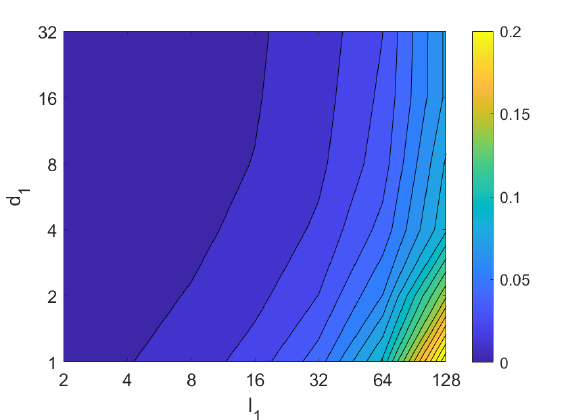
Figure 35. HOG orientation estimation. Average computation time (s).